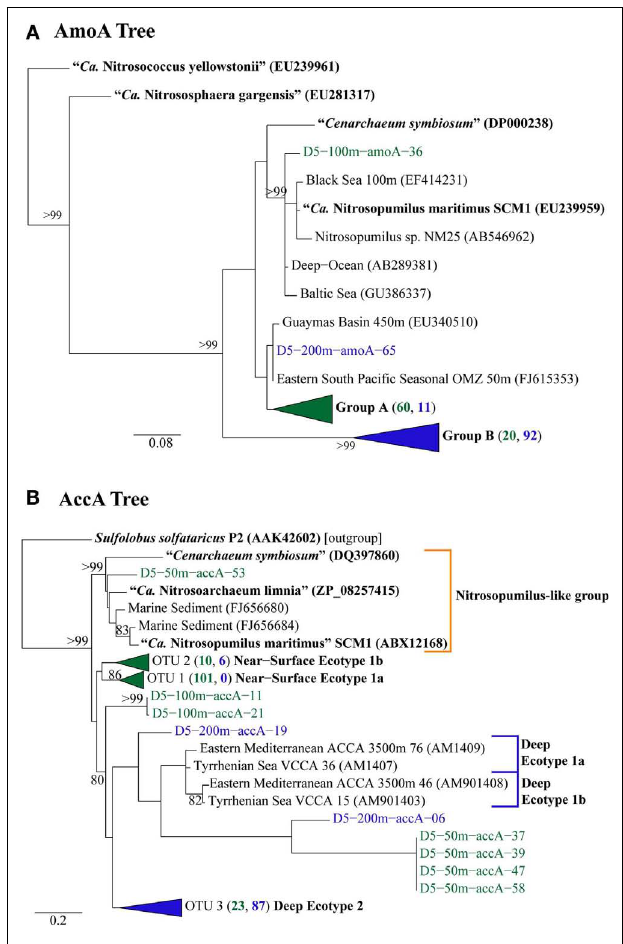
FIGURE 6 | Phylogenetic analysis of inferred amino acid sequences from (A) amoA and (B) accA gene sequences retrieved from Station D5. Numbers beside groups (in triangles) indicate the number of sequences from each depth sampled according to color: clades in green are from 2, 50, or 100m; clades in blue are from 200 or 450m. Neighbor-JoiningTrees were constructed with ARB (Ludwig et al., 2004) from sequences 199 aa (AmoA) or 137 aa (AccA) in length. Sequences in bold were obtained from isolates or enrichment cultures of AOA. Bootstrap values were obtained from 100 resamplings; only values above 75% bootstrap support are